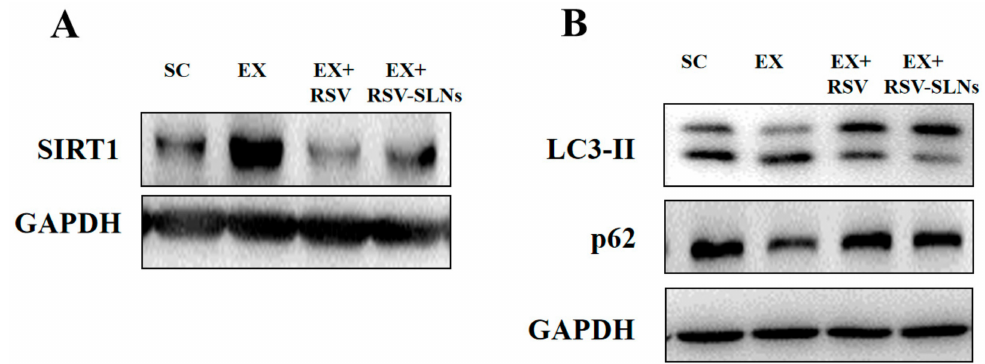
Figure 8. RSV-SLNs regulates SIRT1 and LC3-II / p62 pathway. ( A ) The expression levels of SIRT1 protein was assayed with Western blot analysis. ( B ) The expression levels of LC3-II and p62 protein were detected by Western